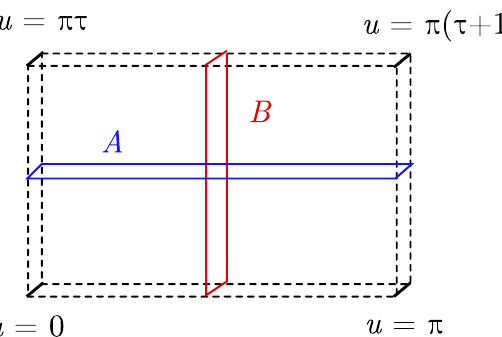
Figure 12. The Z 2 quotient of the torus leads to a double-cover of the sphere which is flat except for conical defects at the corners, with uniformizing coordinates u as indicated. The A and B cycles of the torus can be associated with bulk and boundary OPE channels in the (B)CFT, with insertions at the